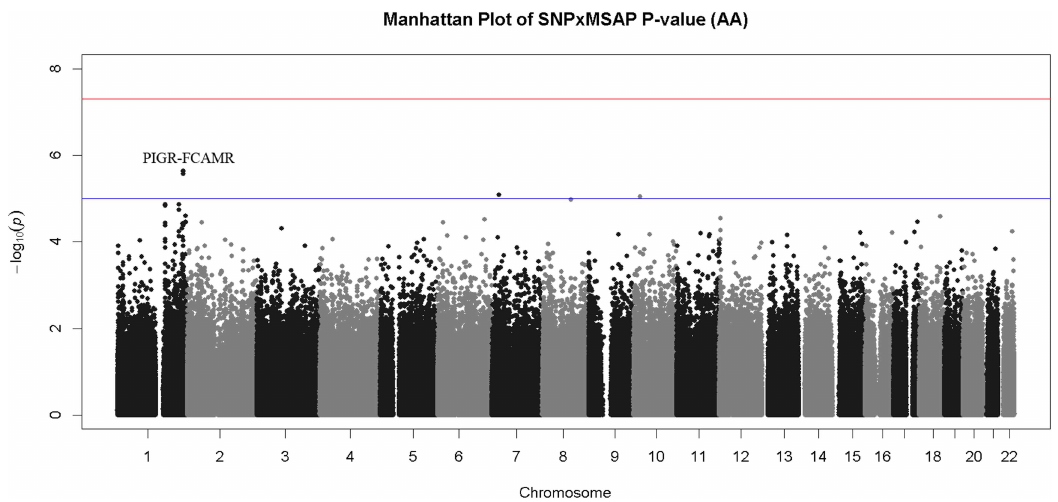
Fig 4. Manhattan Plot of Interaction P-values for AA GWIS. Though no interactions exceededthe genome-wide significancethreshold a cluster of SNP-by-TRAP interactionson chromosome1 ( FCAMR-PIGR locus) exceededthe threshold for suggestiveevidenceof association(P < 1x10 -5 , blue